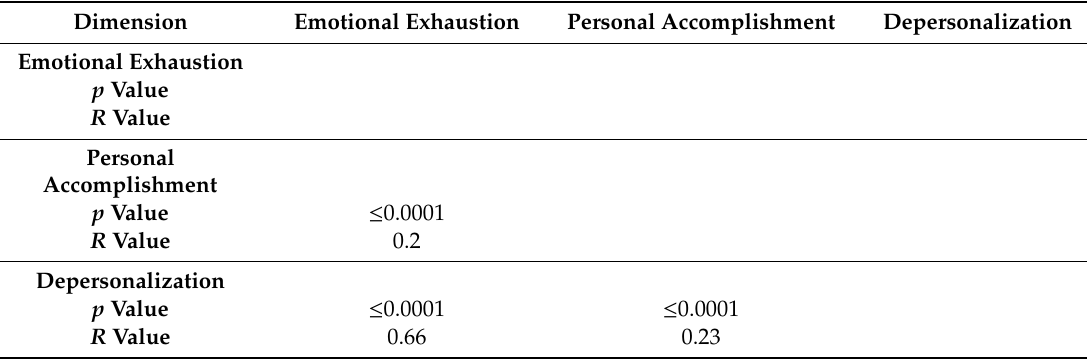
Table 3. Correlation analysis between burnout dimensions (n =